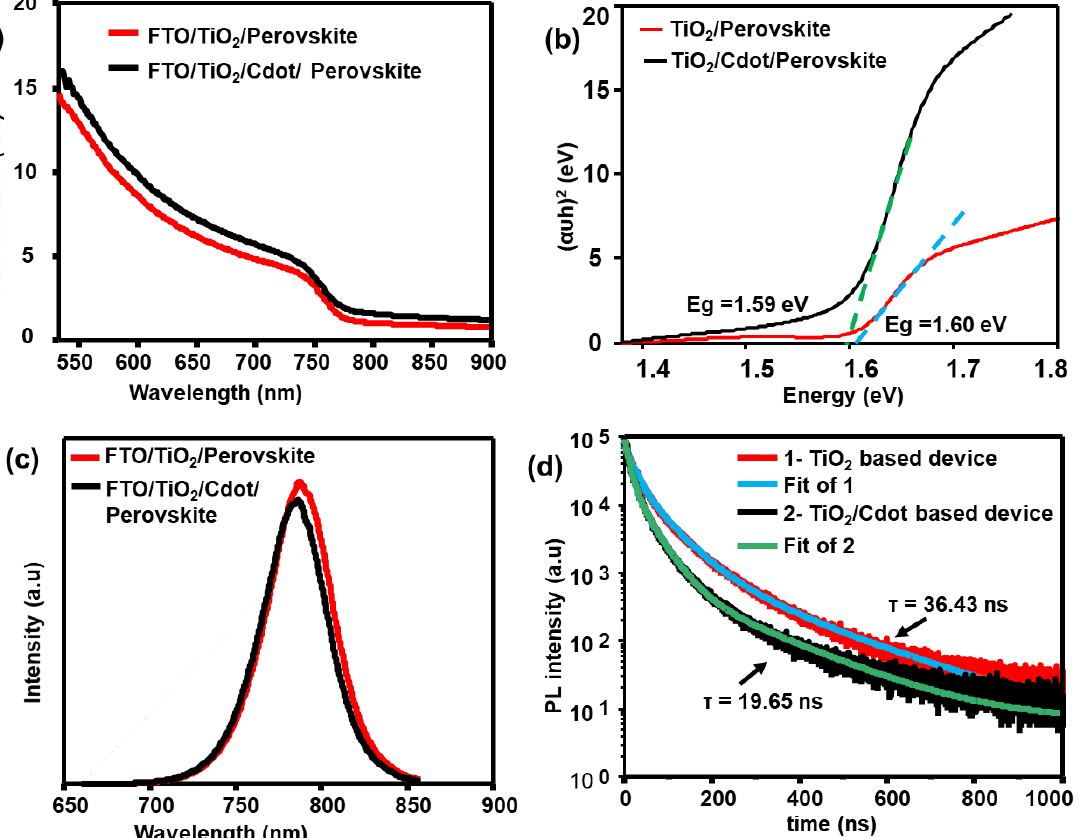
Figure 5. Graph of ( a ) UV–visible absorbance spectra; ( b ) Tauc plots; ( c ) PL spectra; and ( d ) time- resolved photoluminescence plots and fitting curves of meso-TiO 2 and meso-TiO 2 /Cdot based de- vices.